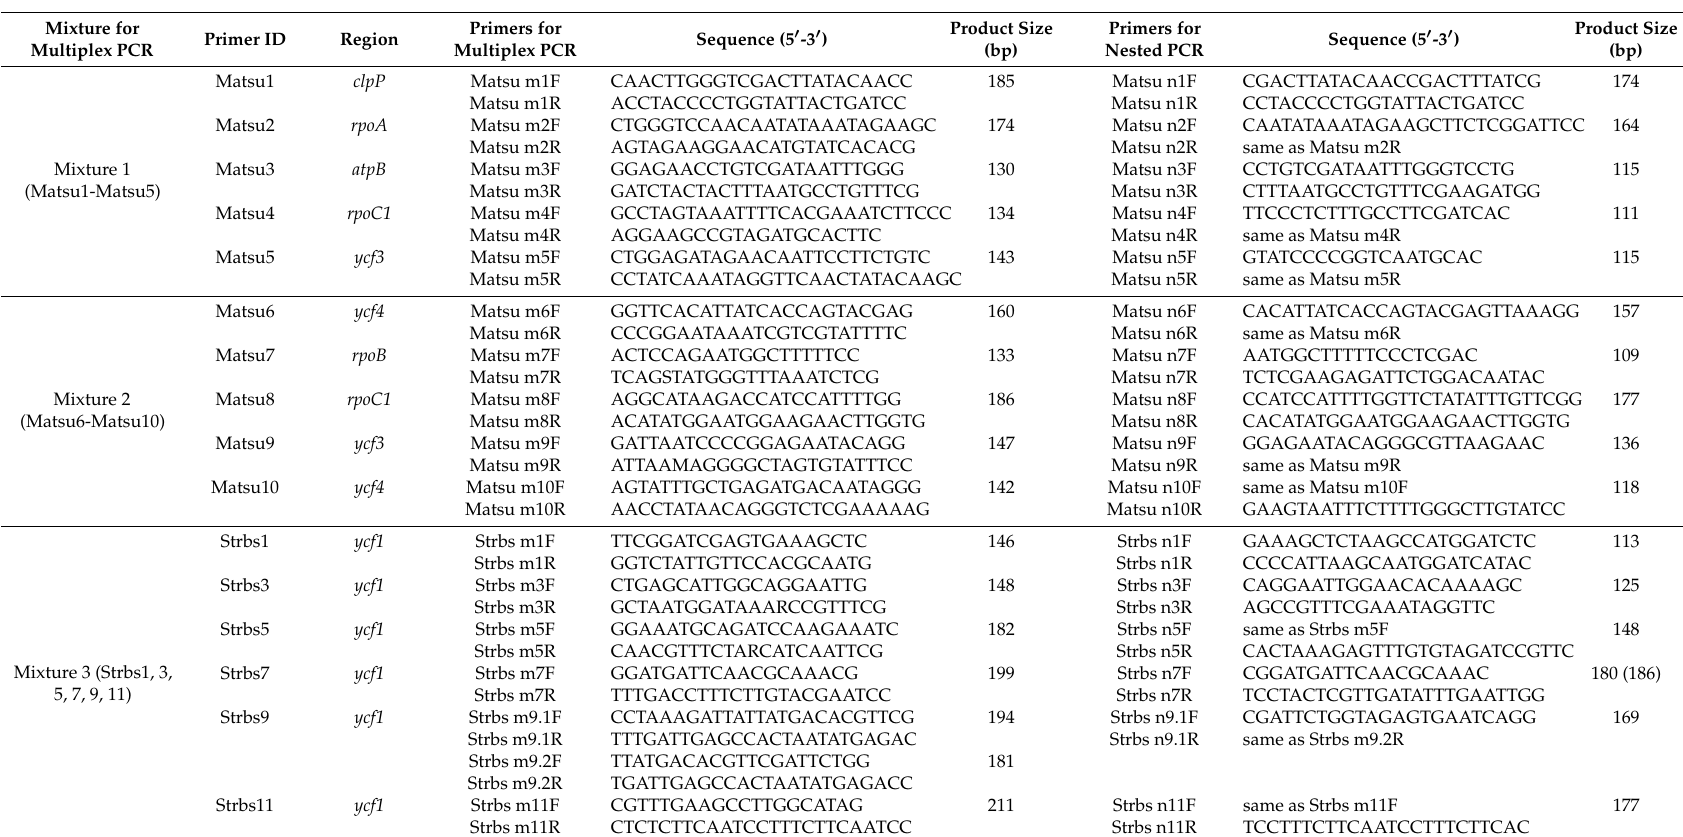
Table 1. Primers for the target fragments used in the present study. The primers for nested PCR for Pns1–7 are not shown because the multiplex PCR products showed no visible band by agarose gel electrophoresis, and an additional round of nested PCR was not performed. Mixture for Multiplex PCR